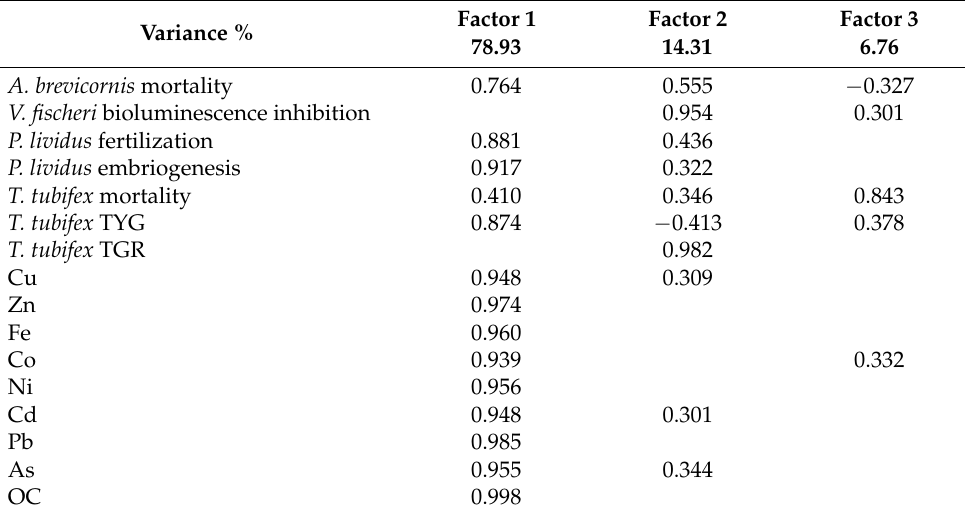
Table 2. Sorted rotated factor loadings of the original variables for the three principal factors results. Variables selected for the interpretation represented a loading of 0.30 or